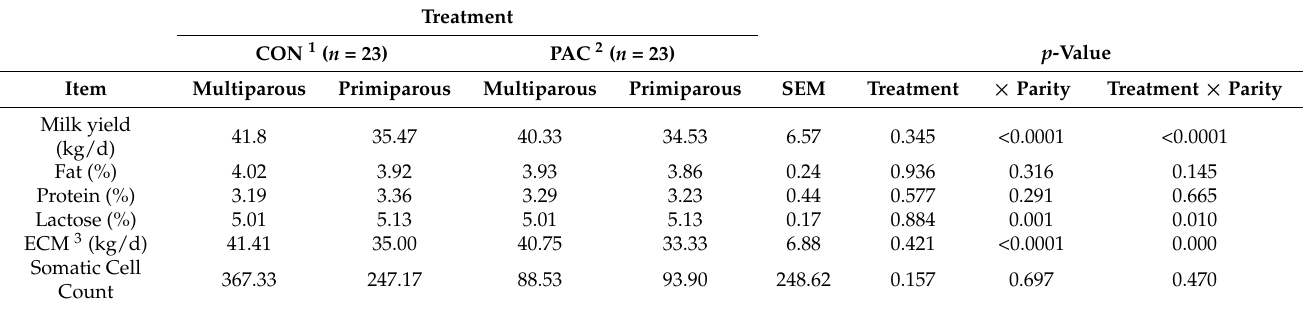
Table 1. Average milk yield and composition from the first three individual milk tests.